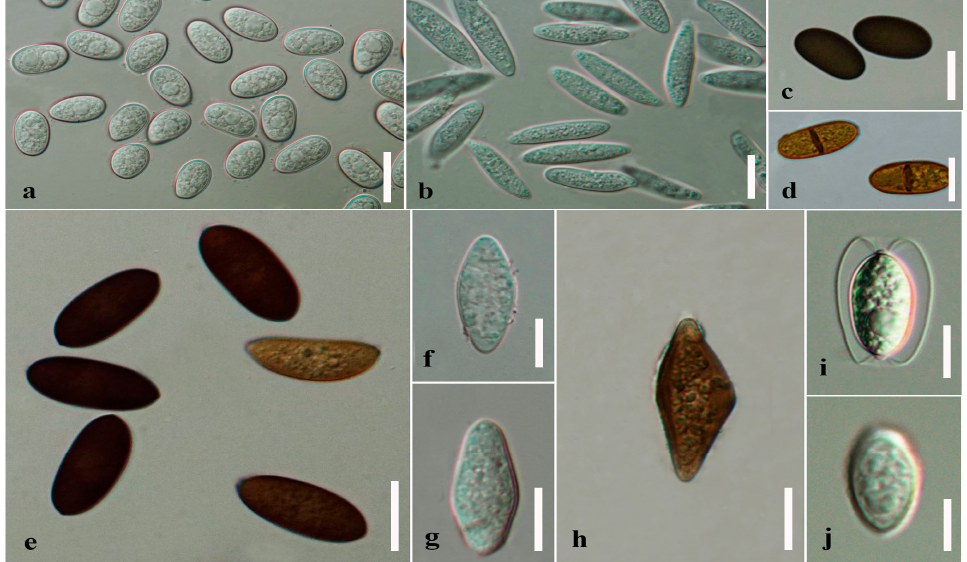
Figure 2. Conidial and ascospore colour and septation. ( a ) Hyaline and aseptate conidia of Lasiodiplodia sp. ( b ) Hyaline and aseptate conidia of Botryosphaeria dothidea . ( c ) Brown and aseptate conidia of Aplosporella thailandica [36]. ( d ) Brown and septate conidia of Dothiorella viticola . ( e ) Brown and aseptate ascospores of Sphaeropsis sp. ( f ) Hyaline and aseptate ascospore of Botryosphaeria fabicerciana . ( g ) Hyaline and aseptate ascospore of Neofusicoccum parvum . ( h ) Brown and aseptate ascospore of Barriopsis archontophoenicis . ( i ) Wing-like appendages of Neodeightonia palmicola ascospore (in water). ( j ) Neodeightonia palmicola ascospore in 100% lactic acid. Scale bars: ( a , d , e ) = 20 µ m, ( b , c , f – j ) = 10 µ m.